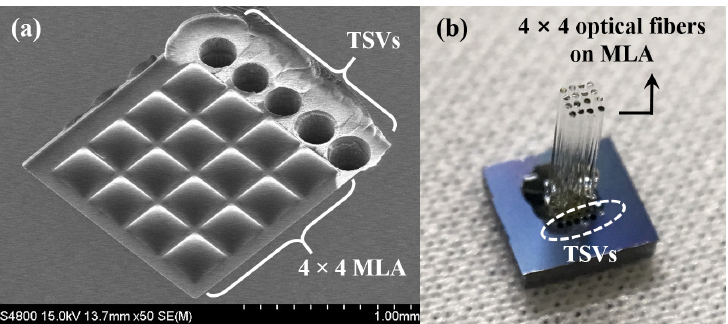
Figure 2. Fabrication results: ( a ) fabricated MLA and TSV; ( b ) 4 × 4 optical fiber array assembled with the MLA.